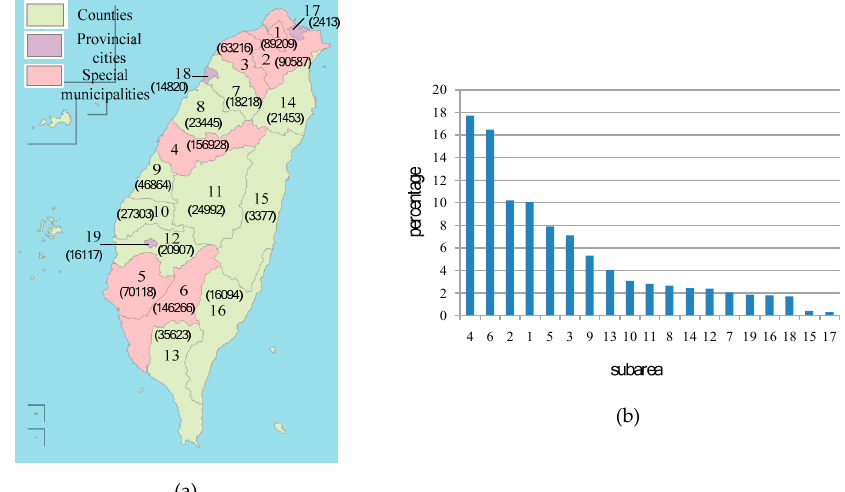
Figure 4. The experimental area with 887,950 points. This area currently contains 6 special municipalities, 10 counties and 3 provincial cities. These subareas are numbered as 1–19: ( a ) The number of points in each subarea. ( b ) The point ratio of each subarea to 16 subareas.